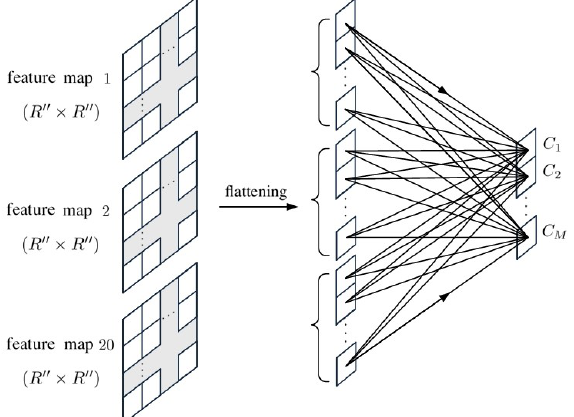
Figure 13. Schematic of FC ( 20 ( R (cid:48)(cid:48) × R (cid:48)(cid:48) ) × M )